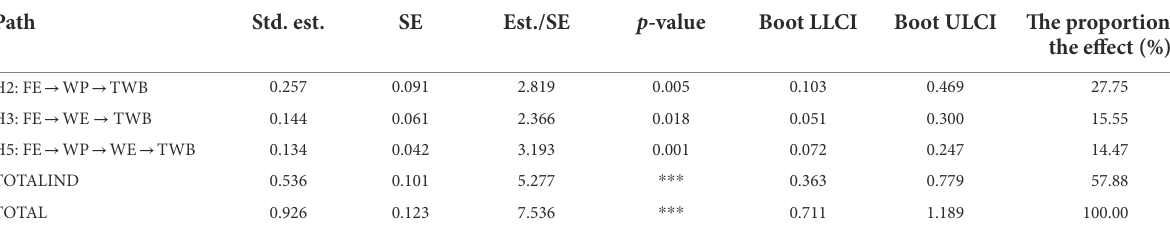
TABLE 5 The indirect effect of the research